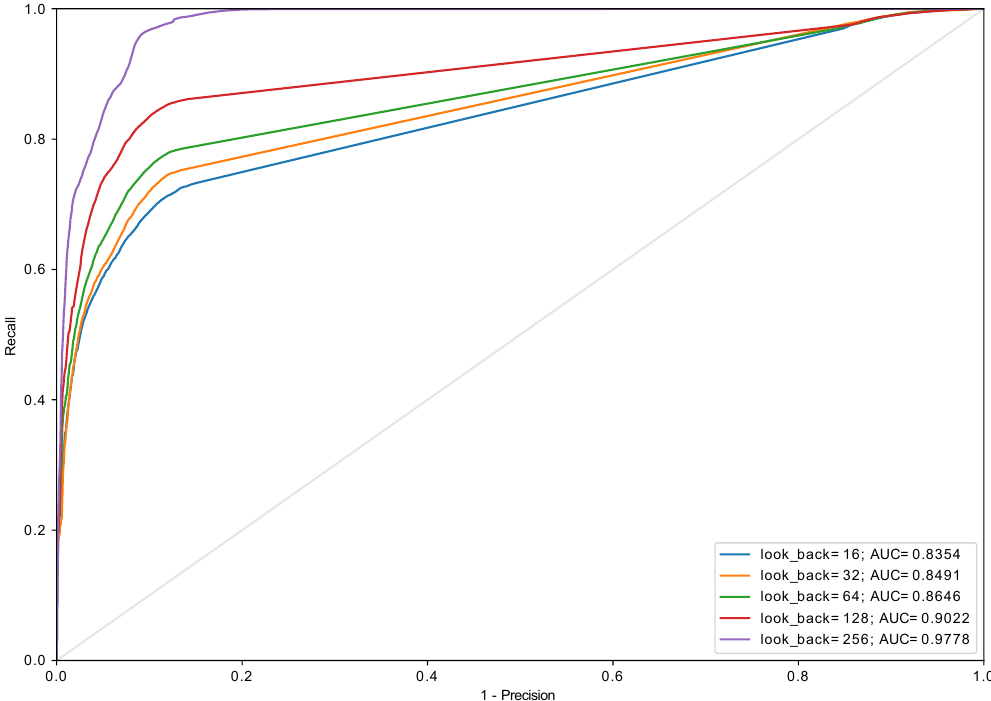
Figure 13. The ROC curve for algorithm adaptive ( in _ algorithm = adaptive , in _ grid = 32, GRU (two layers, 64 and 32 cells) + Dense).